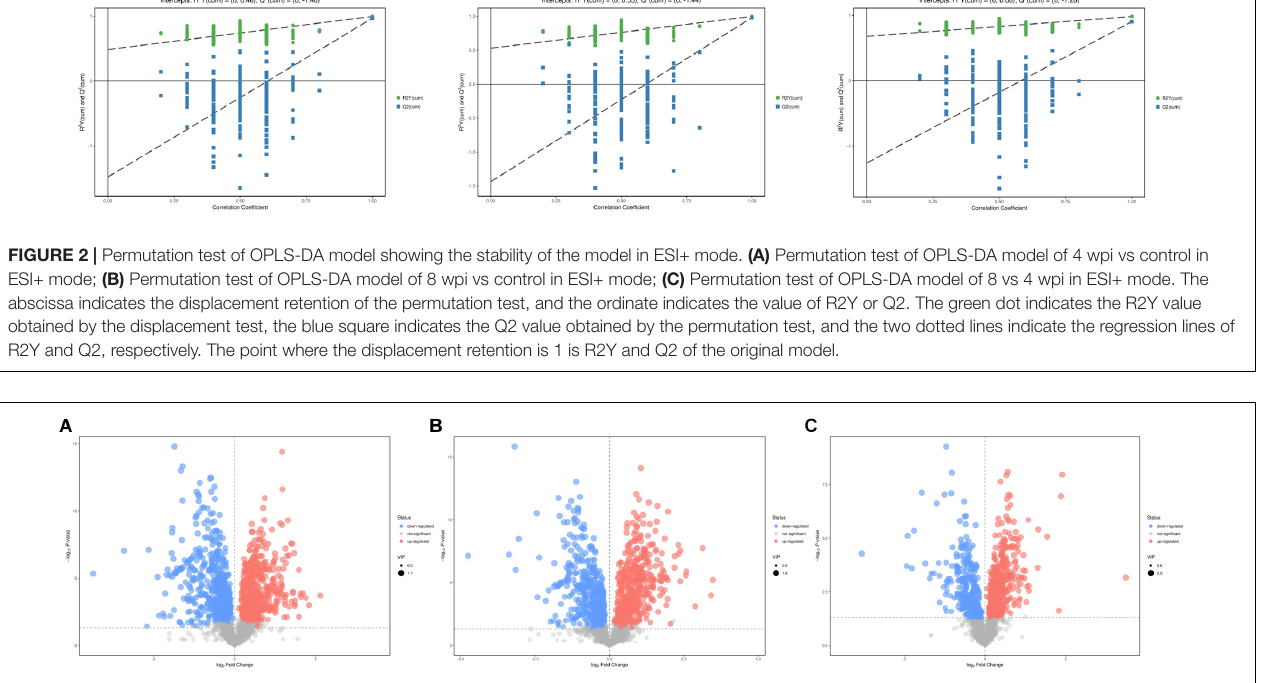
FIGURE 3 | Volcano plot representation of the differential metabolites identified in ESI+ mode. (A) 4 wpi vs control; (B) 8 wpi vs control; (C) 8 vs 4 wpi. Each point in the map represents a metabolite. The size of the scatter represents the VIP value of the OPLS-DA model, and the larger the scatter, the larger the VIP value. Scatter color represents the final screening result, red represents significant up-regulation, blue represents significant down-regulation, and gray represents non-significant difference metabolites.